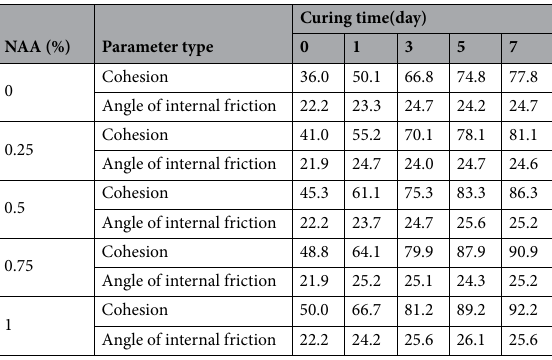
Table 2. Cohesion and internal friction angle.